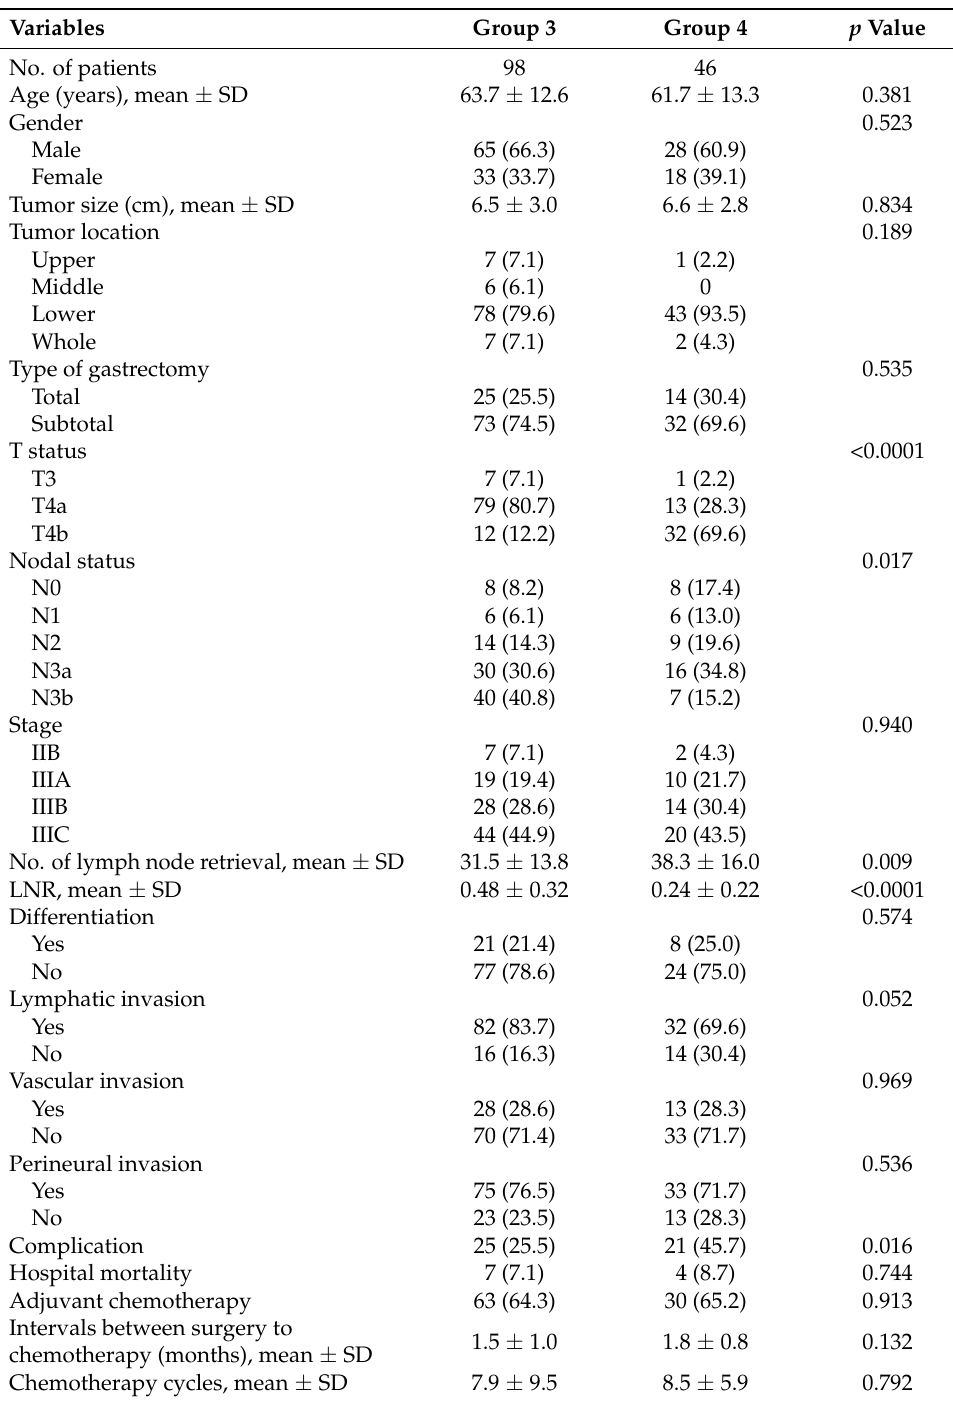
Table 4. Demographics and clinicopathological features between group 3 and 4